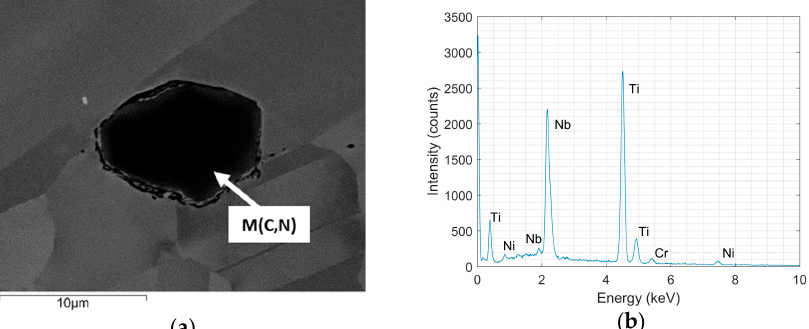
Figure 5. The precipitation of γ ’’ in the segregation band for the samples hot rolled at 1050 °C with the deformation level of 4.6% and aged at 750 °C for 1 h ( a ). Primary MC carbides in the samples hot rolled at 1150 °C with the deformation level of 5.7% and aged at 750 °C for 1 h ( b ). Bulged grain boundary in the samples hot rolled at 1150 °C with the deformation level of 5.7% and aged at 750 °C for 1 h ( c ). Recrystallized grain with no γ ’’ precipitates in the sample hot rolled at 1050 °C with the deformation level of 12.7% and aged at 750 °C for 1 h ( d ).